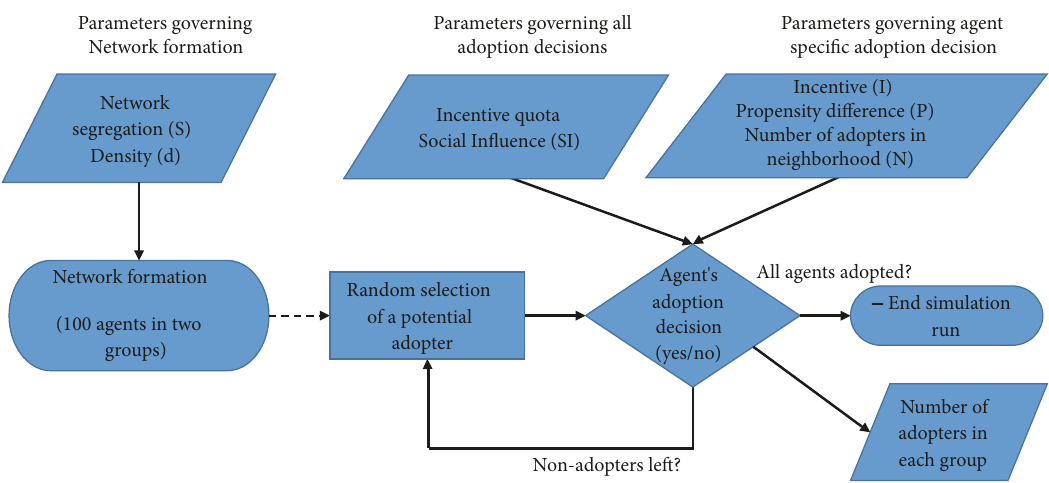
Figure 3: Model overview of one simulation